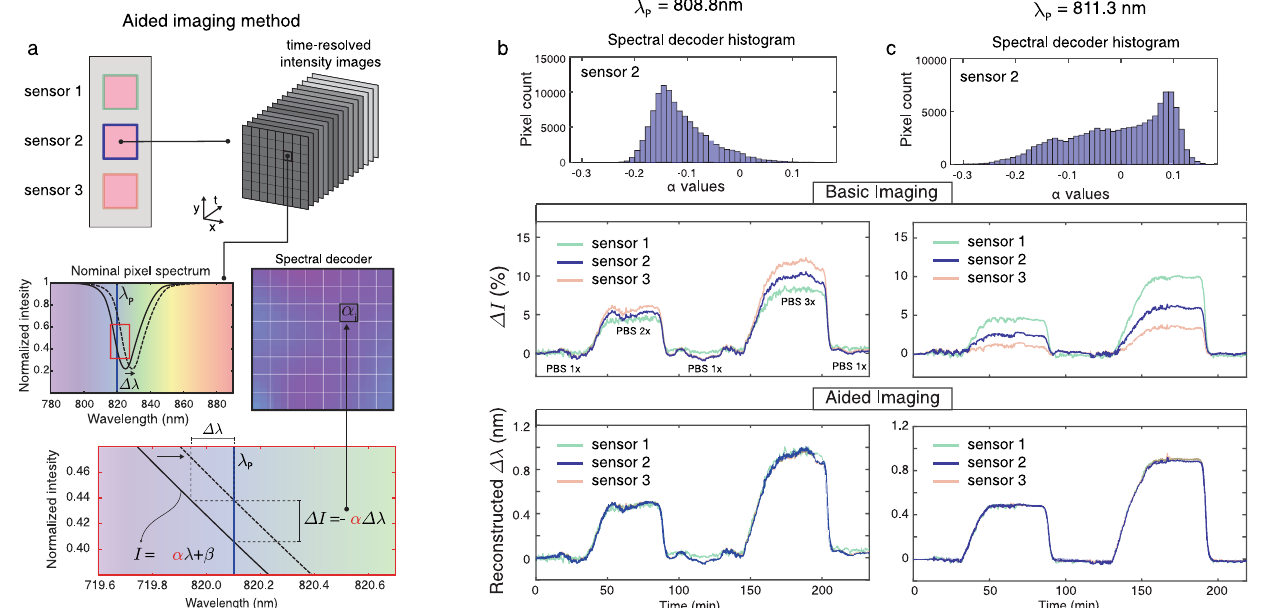
Fig. 3 Implementation of the algorithm-aided imaging technique with reconstructed spectral shift information. a Time-resolved intensity data is fed to the optimal linear estimation algorithm with a spectral decoder, which is the two-dimensional (2D) map of the slope ( α ) of the transmission spectrum for each CMOS pixel at the probing wavelength ( λ p ). b At λ p = 808.8 nm, the histogram of α values from a single sensor is populated mostly with negative values because, for the majority of the pixels, the resonance is probed at the left fl ank of the transmission dip (top panel). This case represents a sensor having a relatively homogenous optical response across its surface. For experimental bulk sensing, under a constant running of phosphate buffer saline (PBS) 1x ( n = 1.33441), three sensors are exposed to a varying medium with PBS 2x ( n = 1.33584) and PBS 3x ( n = 1.33731) and their ensemble-averaged intensity changes ( Δ I , middle panel) and reconstructed spectral shifts ( Δ λ , bottom panel) are presented as a function of time. c At λ p = 811.3 nm, the histogram of the same sensor has a similar number of positive and negative α values (top panel). This case represents a sensor having an inhomogenous optical response. For the same bulk sensing experiment used in Fig. 3b, the ensemble-averaged Δ I response of different sensors shows signi fi cantly varying signals (middle panel). In contrast, the reconstructed spectral shift data obtained by aided imaging (bottom panel) is consistent between the three